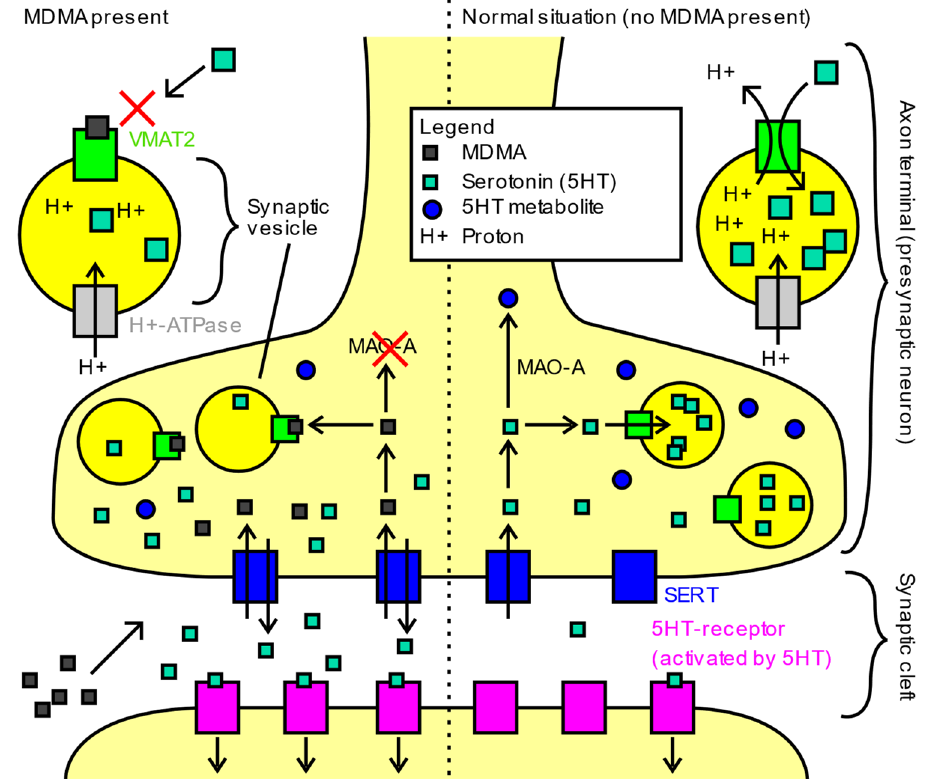
Figure 2. Main mechanisms of action of MDMA in humans. Image obtained from https://commons.wikimedia.org/wiki/File:Main_mechanisms_of_action_of_MDMA_in_humans.svg (accessed on 1 May 2022) and reproduced with permission under the Creative Commons CC0 1.0 Universal Public Domain Dedication.